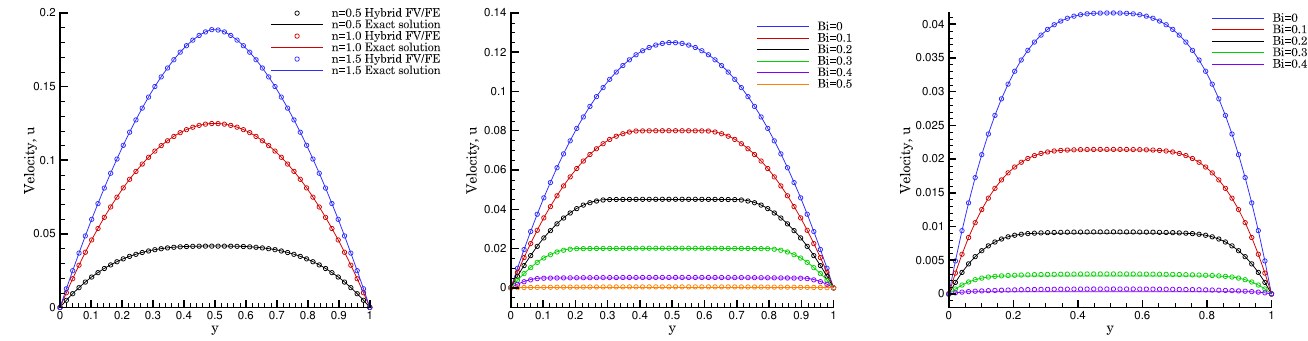
Figure 5. Plane Hagen–Poiseuille of a Herschel–Bulkley flow. Comparison of the numerical solution obtained by using the hybrid FV/FE method with the analytical solution of the Herschel–Bulkley model, given by (47). The consistency parameter is κ = 1. Left plot: the yield stress σ y = 0 and the power-law indexes n = 0.5,1,1.5. Center plot: n = 1 and Bi = 0,0.1,0.2,0.3,0.4,0.5. Right plot: n = 0.5 and Bi =